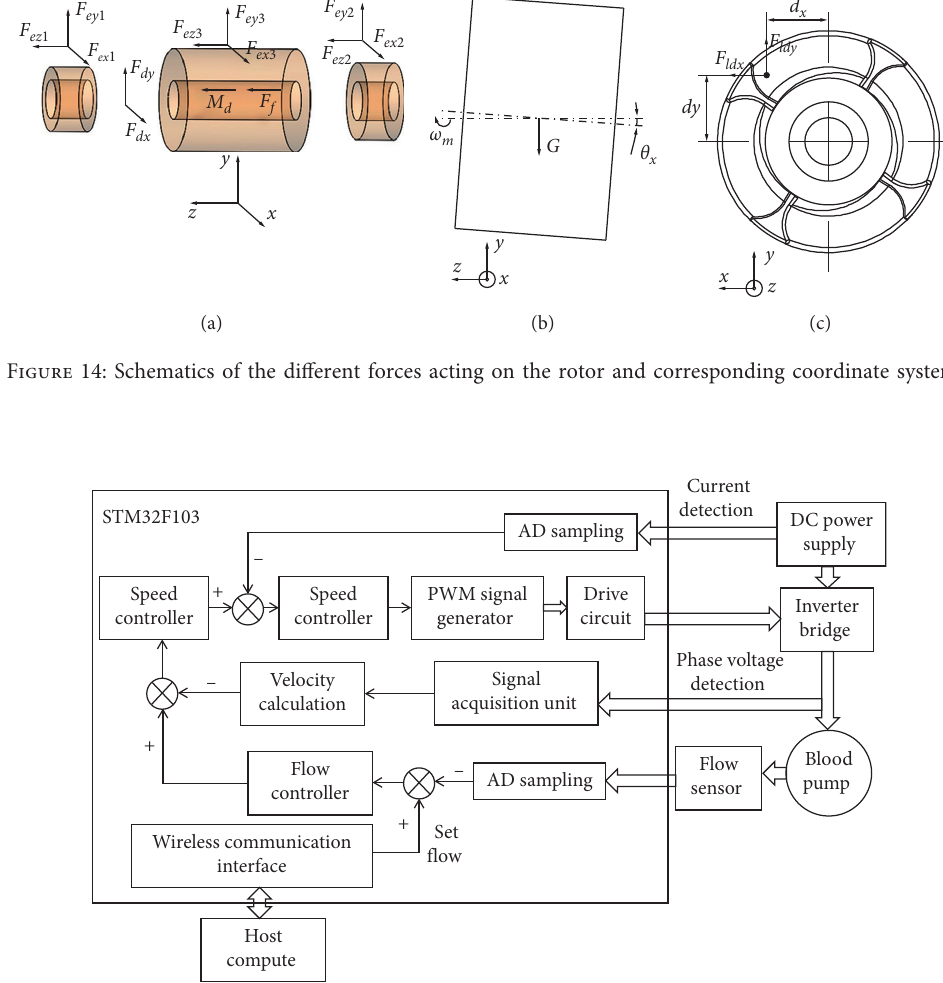
Figure 15: The block diagram of the driven control